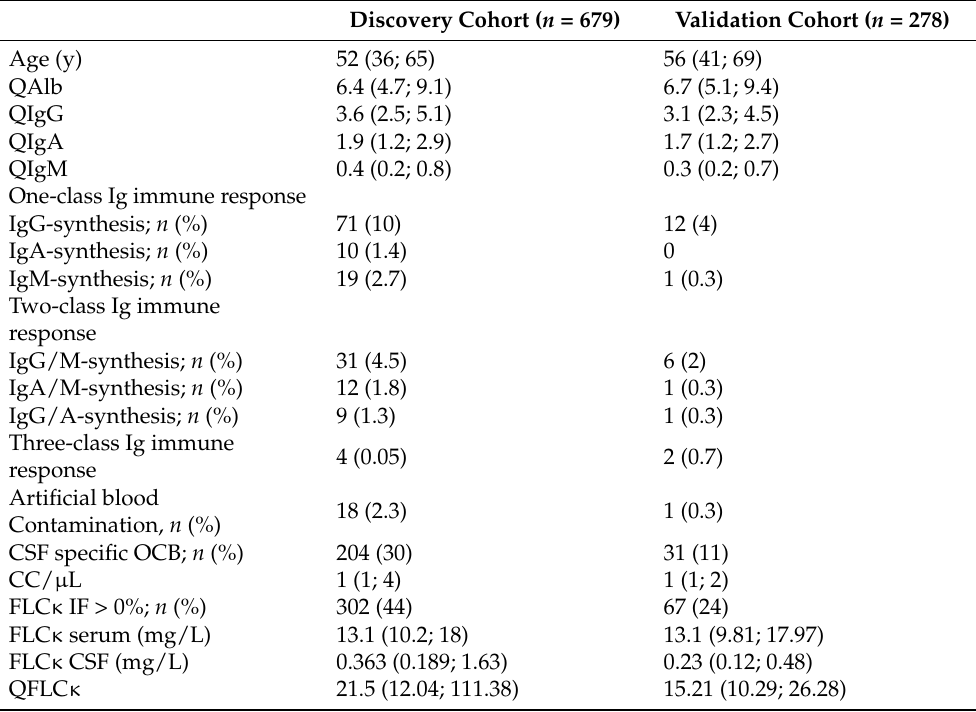
Table 1. Continuous data are expressed as median (first; third quartiles); nominal data are given as percentages, Ig-synthesis are given as quantity and percent. CSF cerebrospinal fluid, OCB oligo- clonal bands, CC cell count (leukocytes), Ig immunoglobulin, QIgG/A/M immunoglobulin G/A/M quotient, QAlb albumin quotient, FLC κ free light chains